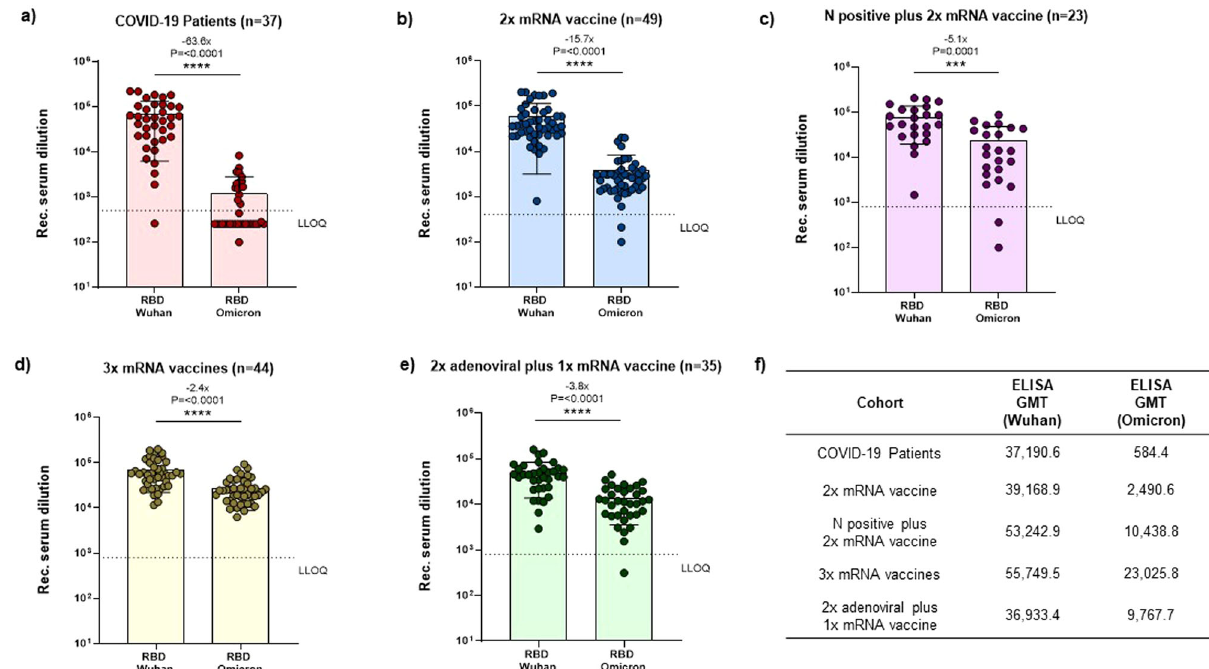
Fig. 1 Anti-IgG ELISA binding titers against ancestral (Wuhan WT) or Omicron BA.1 RBD. a Hospitalized COVID-19 patients (37 subjects); b SARS-CoV- 2- naïve vaccinees immunized with two doses of homologous mRNA vaccine (49 subjects); c previously infected subjects who had received a double dose of homologous mRNA vaccine (23 subjects); d vaccinees boosted with a third dose of mRNA after completion of primary double-dose vaccination with mRNA-based (homologous) vaccine (44 subjects); e vaccinees boosted with a third dose of mRNA after completion of primary double-dose vaccination with adenovirus-based (heterologous) vaccination (35 subjects); f ELISA Geometric mean titers (ELISA GMT) for each cohort and for ancestral virus and Omicron BA.1 variant. Y axis shows the reciprocal of serum dilutions (Rec. serum dilution). Data points show individual serum ELISA titers (average of two replicates). The ELISA titer is represented as the reciprocal of the highest serum dilution able to provide an absorbance value greater than the cut-off value. ELISA GMTs for each cohort are shown. Error bars indicate the GMT of the group ± standard deviation. Fold-changes in GMT are reported above histograms. P values were calculated by means of the Mann – Whitney U-test. Horizontal dashed line represents the Lower Limit of Quanti fi cation (LLOQ) of the assay. Different LLOQ were set according to the expected response of each cohort (COVID-19 patients LLOQ: 500; 2x mRNA vaccine LLOQ: 400; N positives plus 2x mRNA vaccines LLOQ: 800; 3x mRNA vaccine LLOQ = 800, 2x adenoviral plus 1xmRNA vaccine LLOQ: